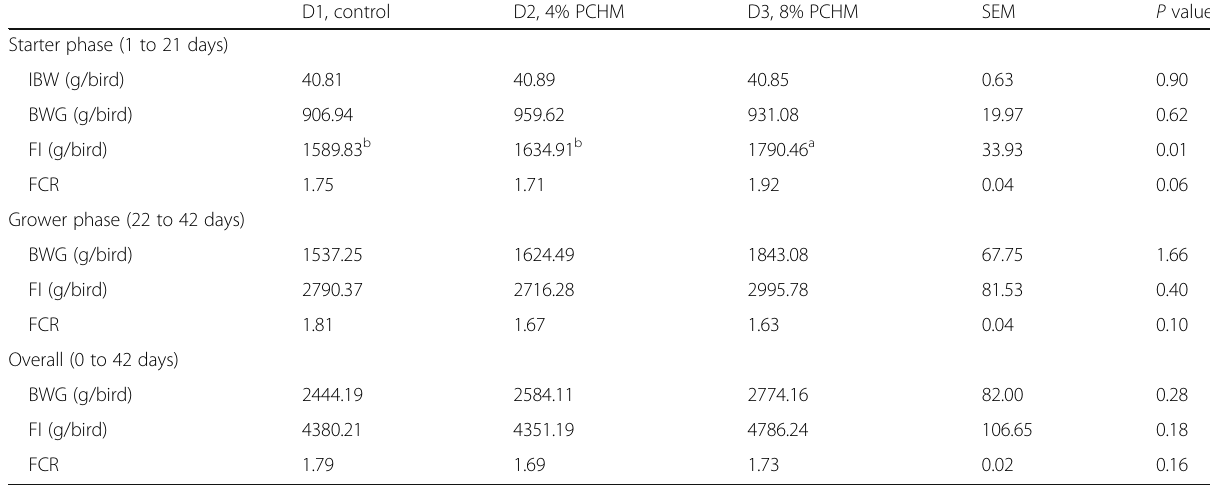
Table 4 Effects of processed cocoa pod husk meal (PCHM) on performance of broiler chickens